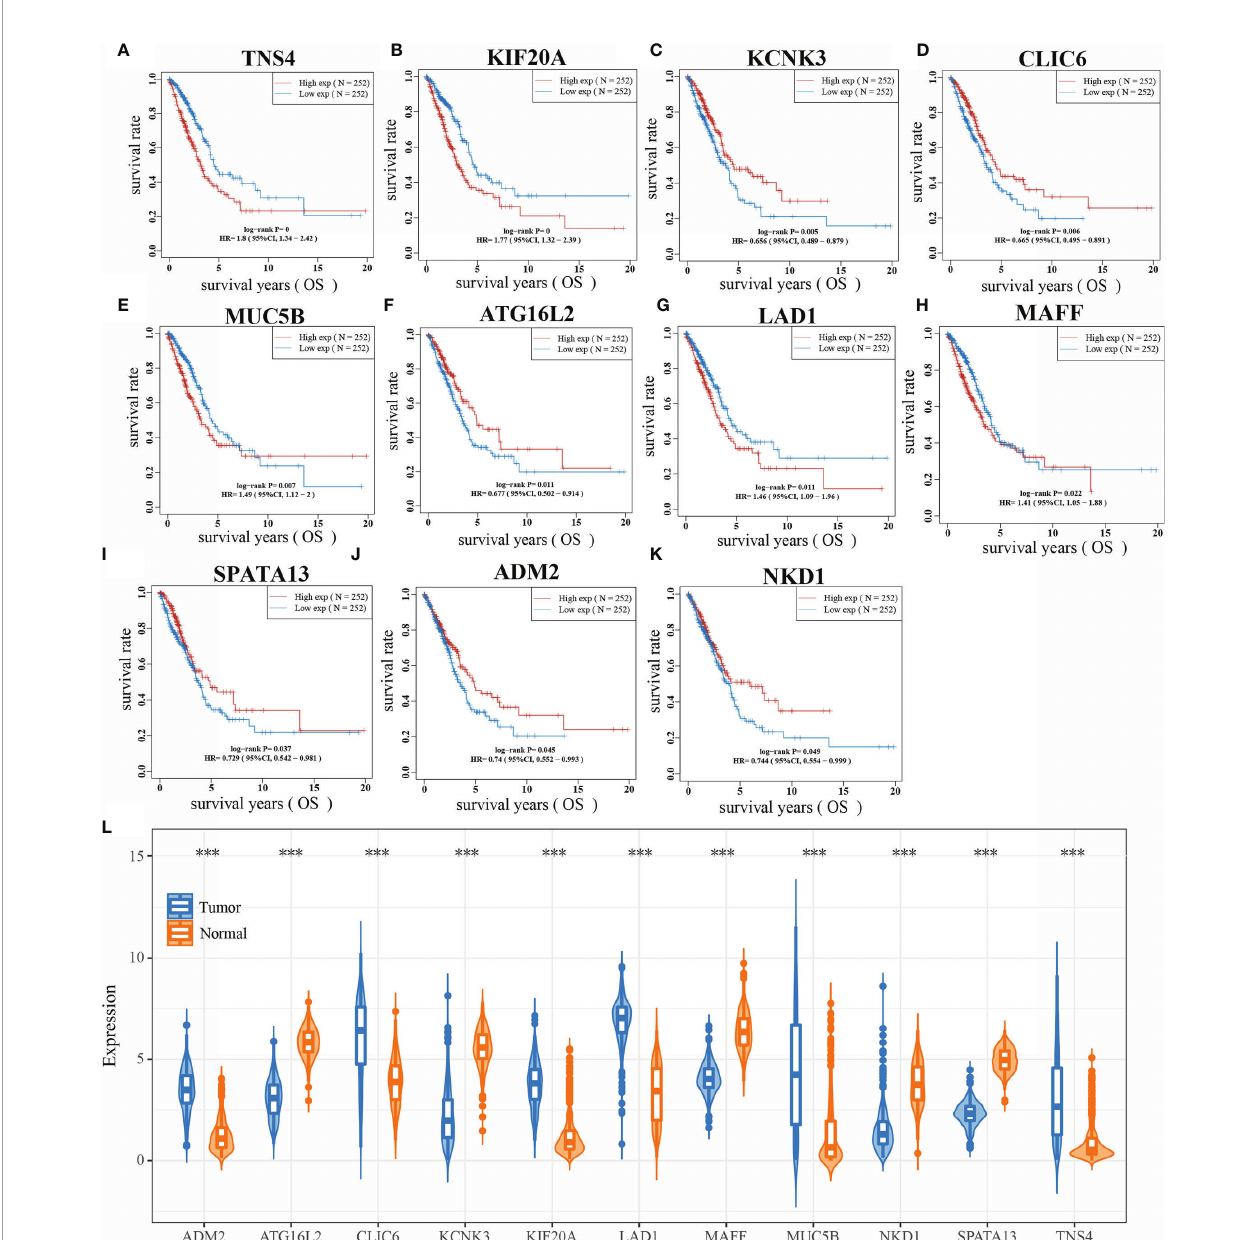
FIGURE 5 | Kaplan-Meier method to validate 23 genes. ( A : KM curve of TNS4; B : KM curve of KIF20A; C : KM curve of KCNK3; D : KM curve of CLIC6; E : KM curve of MUC5B; F : KM curve of ATG16L2; G : KM curve of LAD1; H : KM curve of MAFF; I : KM curve of SPATA13; J : KM curve of ADM2 curve; K : KM curve of NKD1; L : expression of 11 genes in LUAD; ***P <